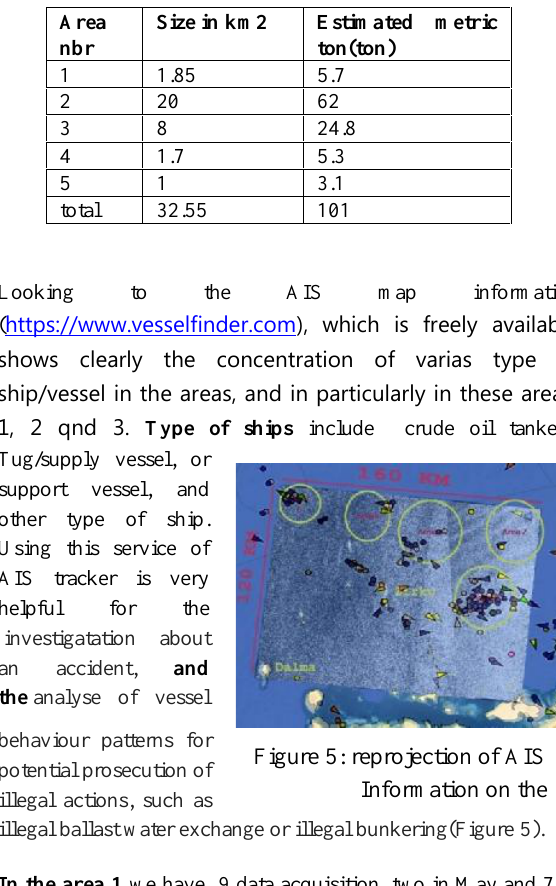
Figure 3: location map of oil spill